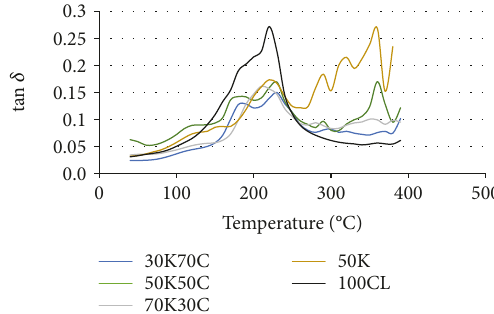
Figure 6: tan δ of the hybrid